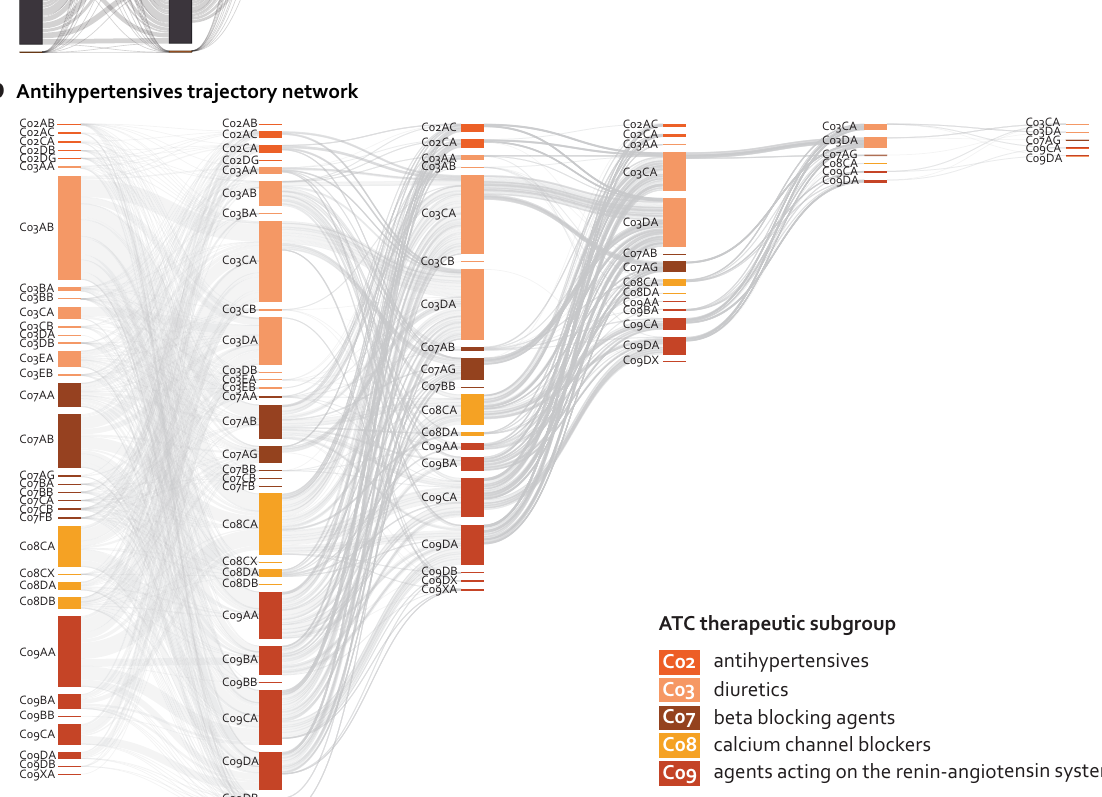
Fig. 3 Prescription trajectory space. a All statistically signi fi cant prescription trajectories followed by more than 1000 patients are represented in this interconnected network. The order of the trajectories and the organization of the network is arbitrary. The length of the trajectory is depicted by the number of nodes it contains (from left to right, ranging from 2 to 8). The heterogeneity of prescription trajectories is depicted here. b Alluvial plot of the chemical subgroups used in treatment for hypertension, including C02, C03, C07, C08, C09 (antihypertensives, diuretics, beta blocking agents, calcium channel blockers, and agents acting on the renin-angiotensin system, respectively). The plot is ordered by length from left to right, and arbitrarily by chemical subgroup from top to bottom. The edge height represents the number of people that move from one node to the next (going left to right). Note that patients can follow more than one trajectory at the same time. *Refer to Fig. 1 for ATC group legend